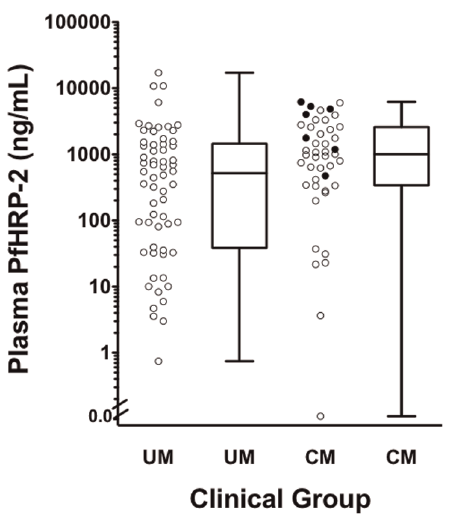
Figure 1. Plasma P.falciparum histidine-rich protein-2 concen- tration in children with uncomplicated and cerebral malaria. Dot plots showing plasma PfHRP-2 concentration value; box plots showing median, interquartile range, maximum and minimum for plasma PfHRP-2 in uncomplicated malaria (UM) and cerebral malaria (CM). Open circles = recovery, closed circles =